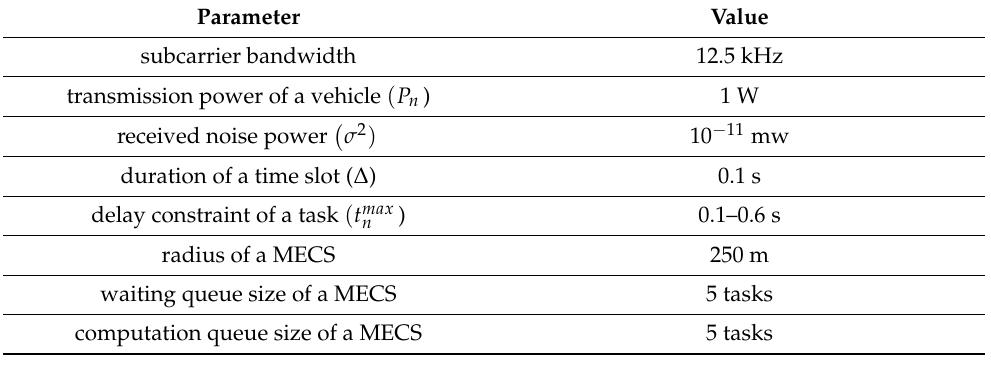
8 of 15 Table 1. Parameters used in the simulation. Parameter Value subcarrier bandwidth 12.5 𝑘𝐻𝑧 transmission power of a vehicle ( 𝑃 (cid:3041) )